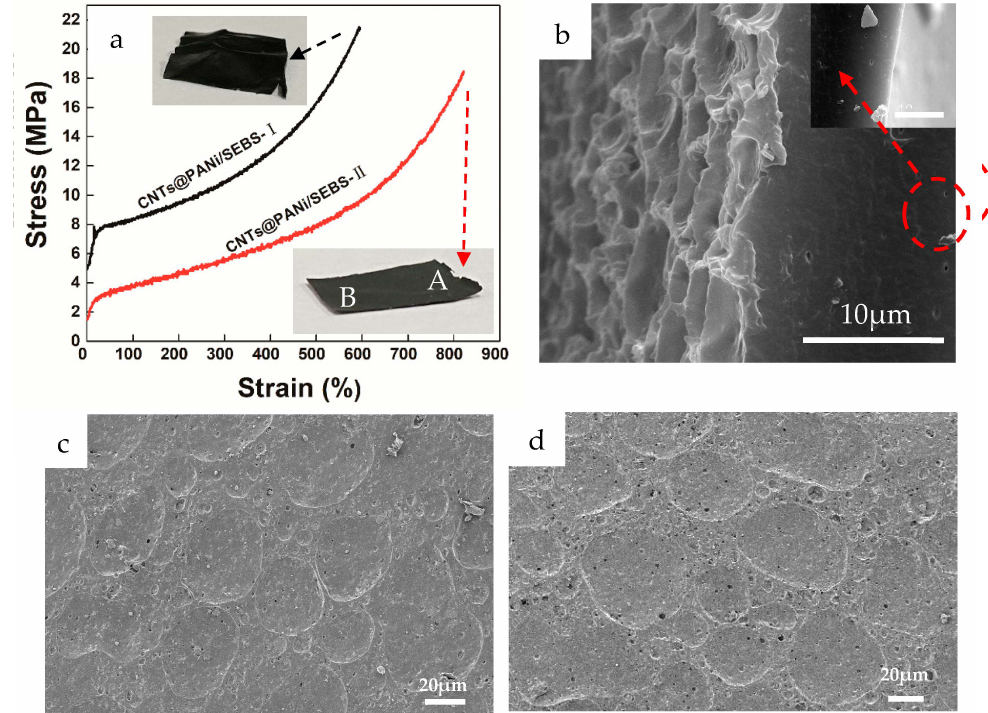
Figure 5. ( a ) Tensile stress-strain curves, with digital film photos after fracture; SEM images of CNTs@PANi/SEBS- Ⅱ bilayer film for ( b ) tensile fractured cross-sections; ( c ) surface after tensile fracture, area A; ( d ) surface after tensile fracture, area B.